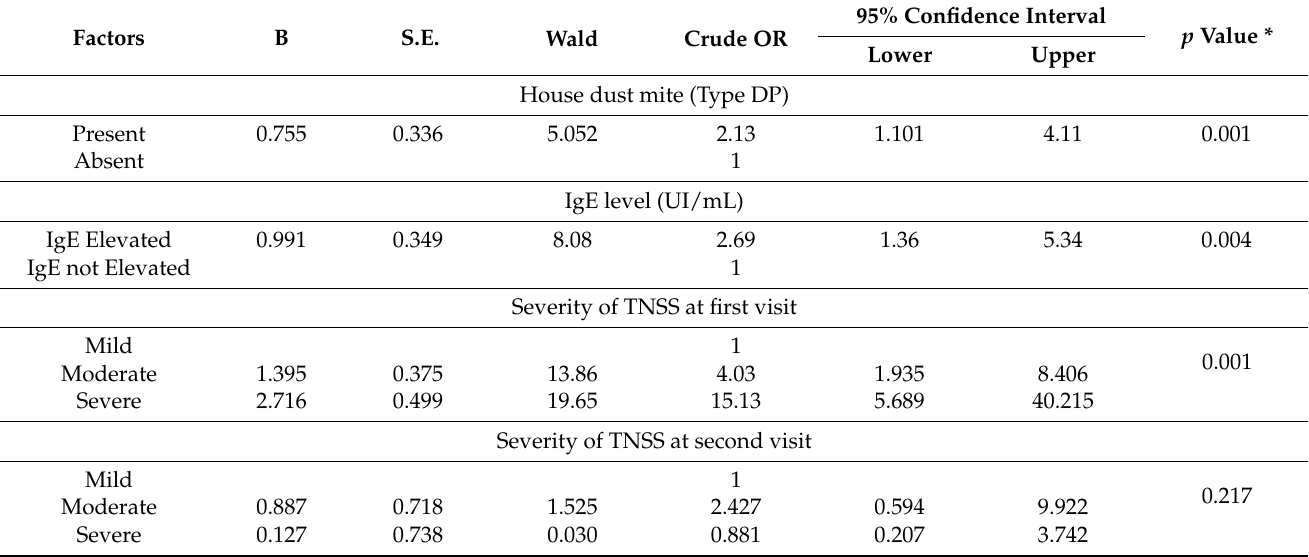
Table 4. Post-hoc analysis of significant factors affecting medication adherence to intranasal corticosteroids.